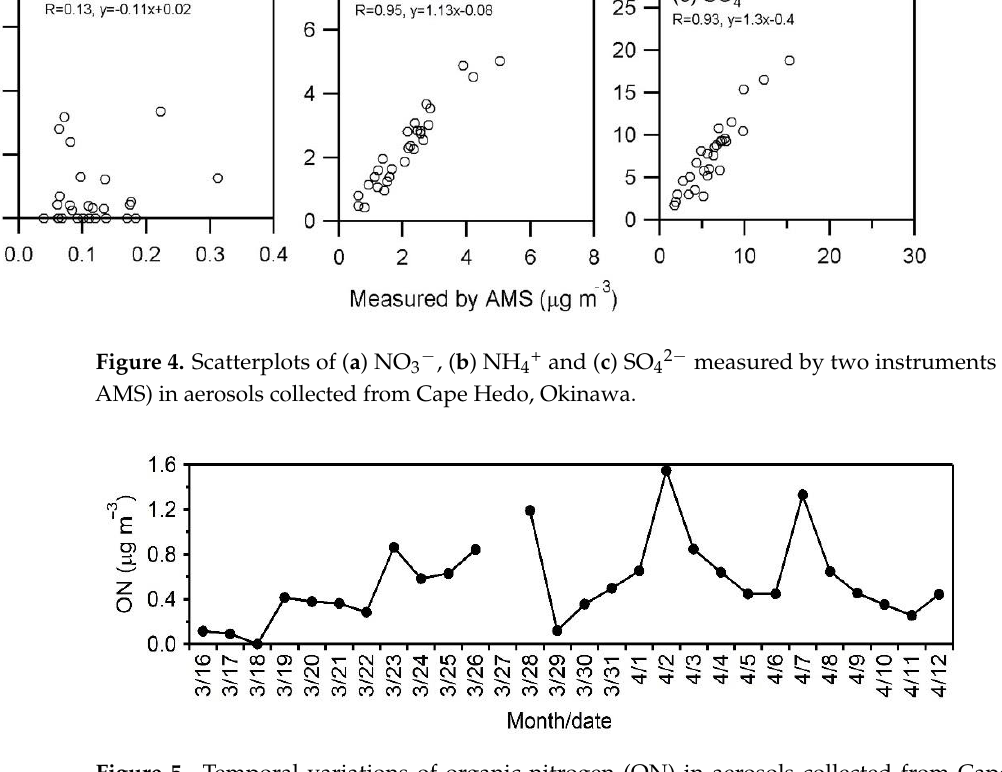
Figure 5. Temporal variations of organic nitrogen (ON) in aerosols collected from Cape Hedo, Oki- nawa.